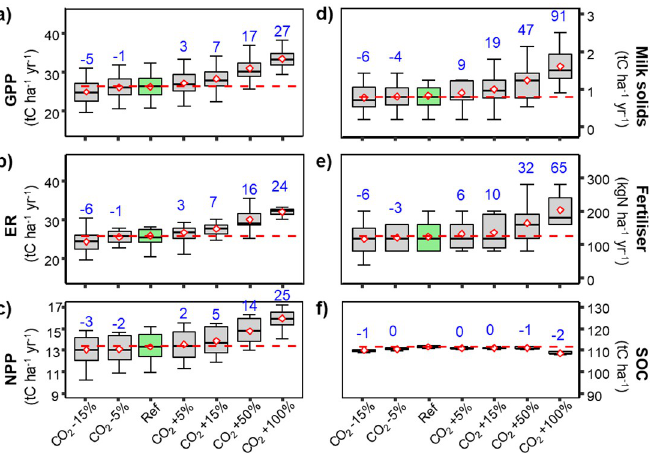
Fig 3. Box and whiskers charts for modelled variables under a range of different atmospheric CO 2 concentrations. Details as for Fig 1.